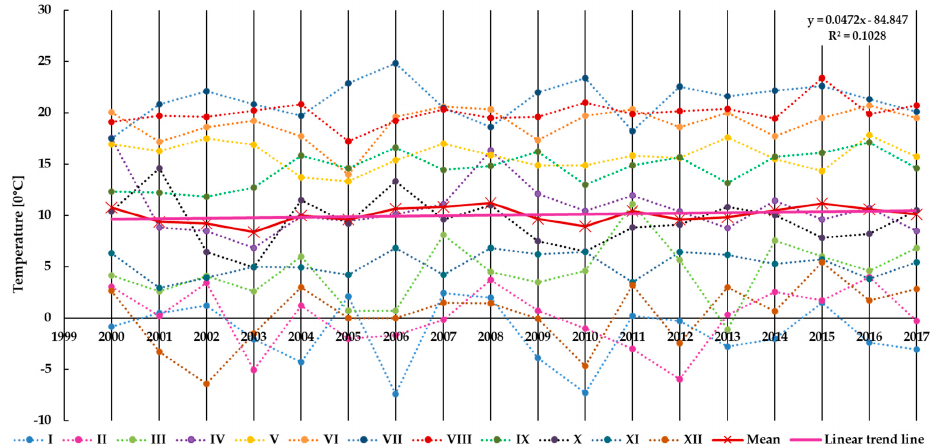
Figure 4. The means of monthly and yearly air temperatures (°C) in the years 2000–2017, measured in the PAS Botanical Garden CBDC in Powsin, and the linear trend line of increase of the average yearly temperature in this period (adapted with permission from Ref. [45] 2021, MDPI).